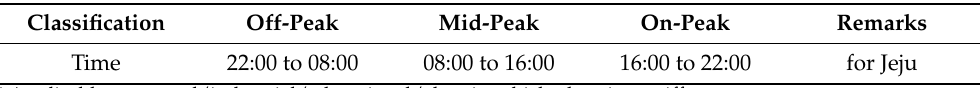
Table 11. Classification of peak time which affects electricity rate * [26]. Classification Off-Peak Mid-Peak On-Peak Remarks Time 22:00 to 08:00 08:00 to 16:00 16:00 to 22:00 for